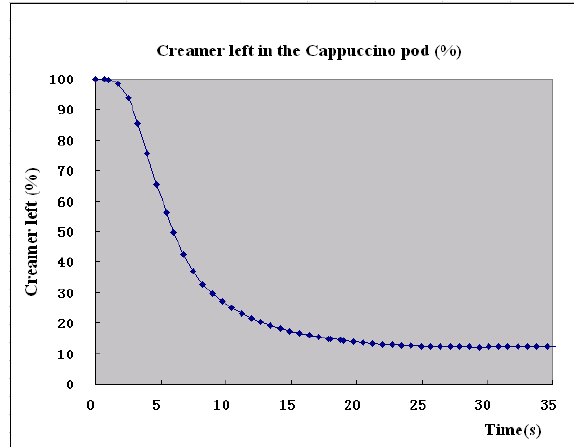
Fig. 7. Factors that can influence the dissolution of the creamer in the